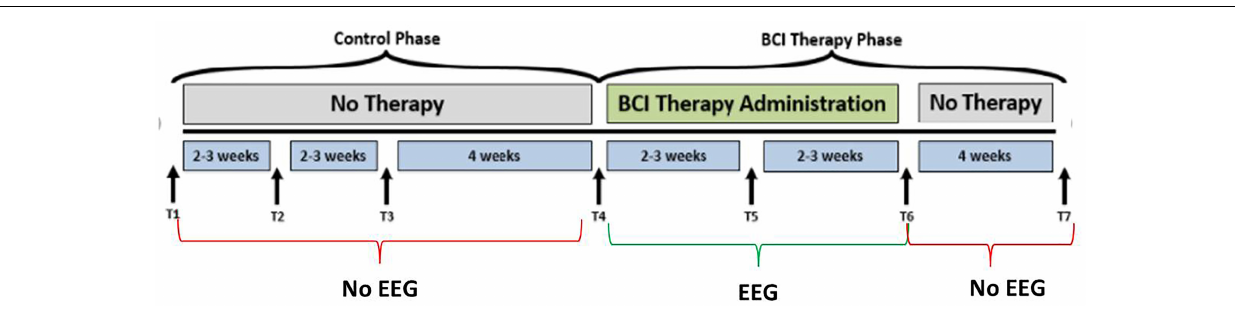
FIGURE 1 | Study design. The time-points at which neuroimaging data were collected are represented by, T1, control baseline; T2, control middle; T3, control completion; T4, intervention baseline; T5, mid-intervention; T6, completion of intervention; T7, 1-month post-intervention. While the crossover control group (DTG) completed visits T1 through T7, the immediate therapy (ITG) group completed only visits T4 through T7. EEG-BCI-FES intervention is only administered during the BCI Therapy Phase (green), from baseline (T4) to completion (T6), and EEG recordings are neither acquired between T1 and T4, nor between T6 and T7 during which only MRI and behavioral testing batteries are administered. EEG data were only collected during the intervention